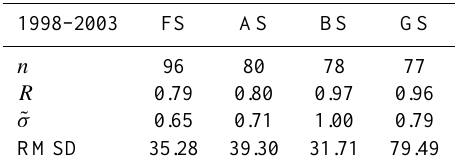
Table 4. The same statistics like in Table 3 but for a six year